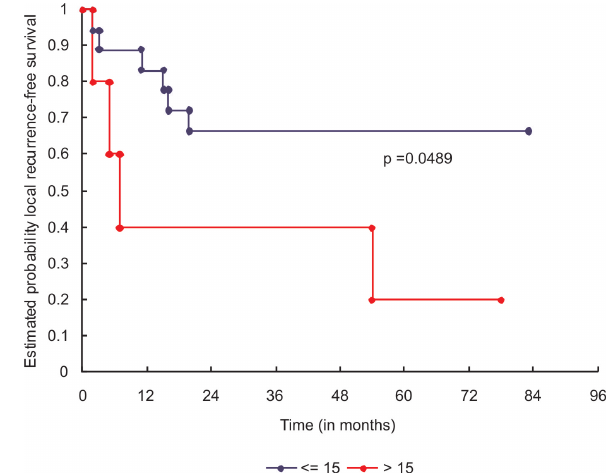
Figure 7 - Curve of local recurrence-free survival in months for the 23 patients with primary osteosarcoma that was non-metastatic at diagnosis, according to tumor size